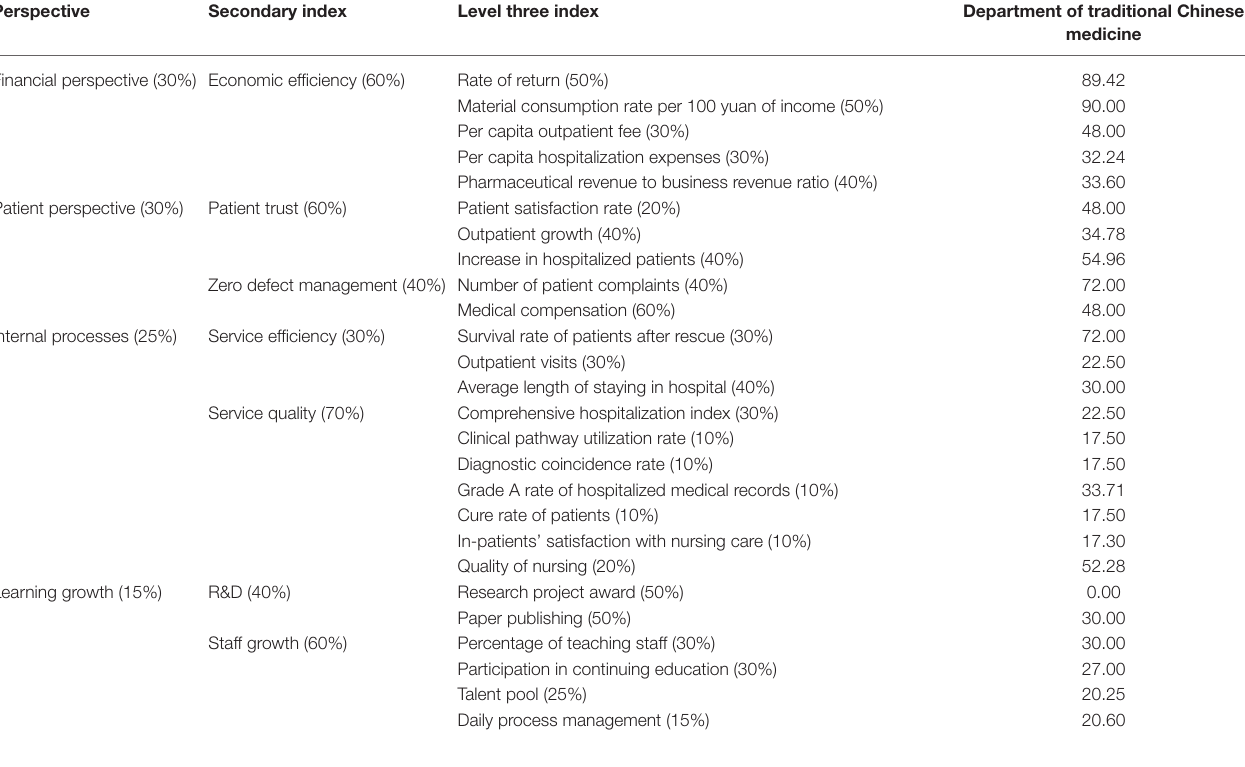
TABLE 10 | Comprehensive scores of performance assessment of clinical